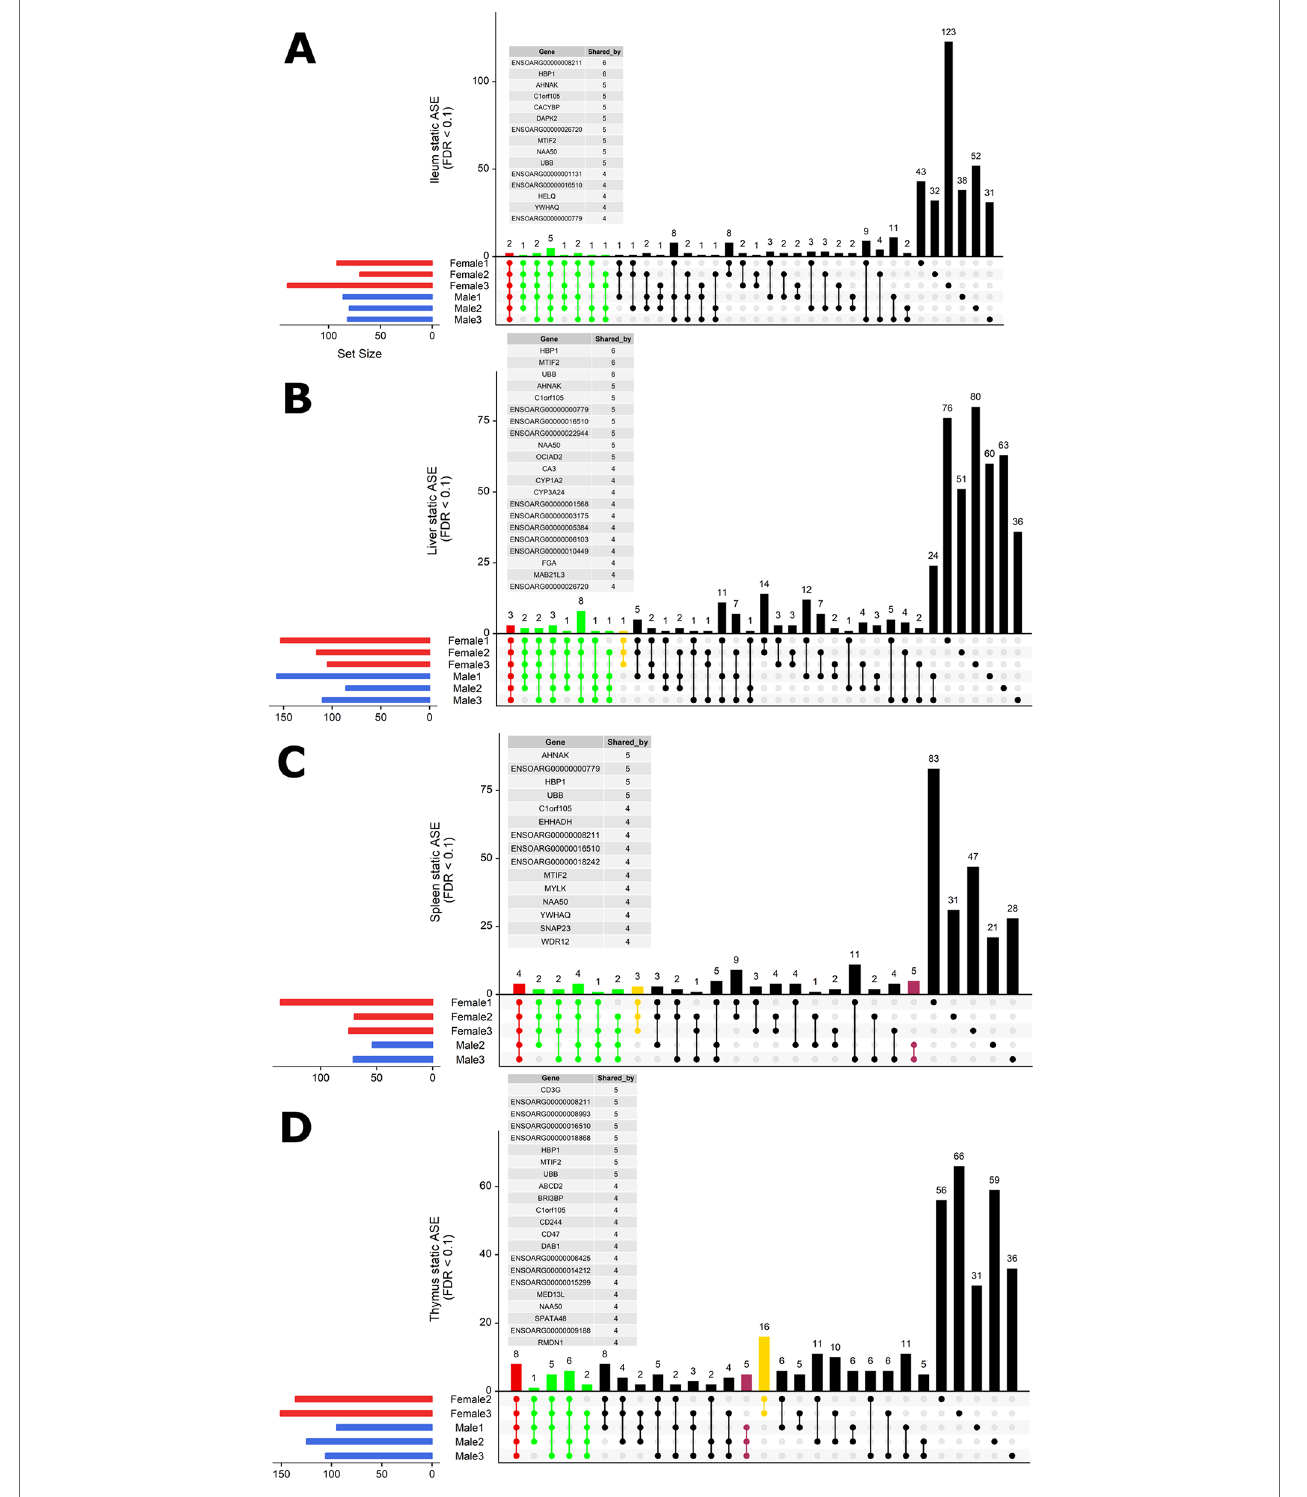
FIGURE 5 | Intersectionality analysis of genes expressing significant ASE across all six sheep. In each tissue from left to right, the set count of genes (dots connected by lines) illustrates the number of sheep sharing the gene. The private sets of genes are located at the far right of each graph (single dots with no line). The intersections are colored in to illustrate the size of the set of shared genes (red [common to all six sheep], green [shared by five or four sheep], yellow [only in females] and purple [only in males]). Detailed lists of genes with ASE shared by at least four sheep are presented above each graph for (A) ileum, (B) liver, (C) spleen, and (D) thymus. Two sex-specific sets of genes are highlighted: 16 genes showing ASE only in females (in yellow) and five genes only in males (in